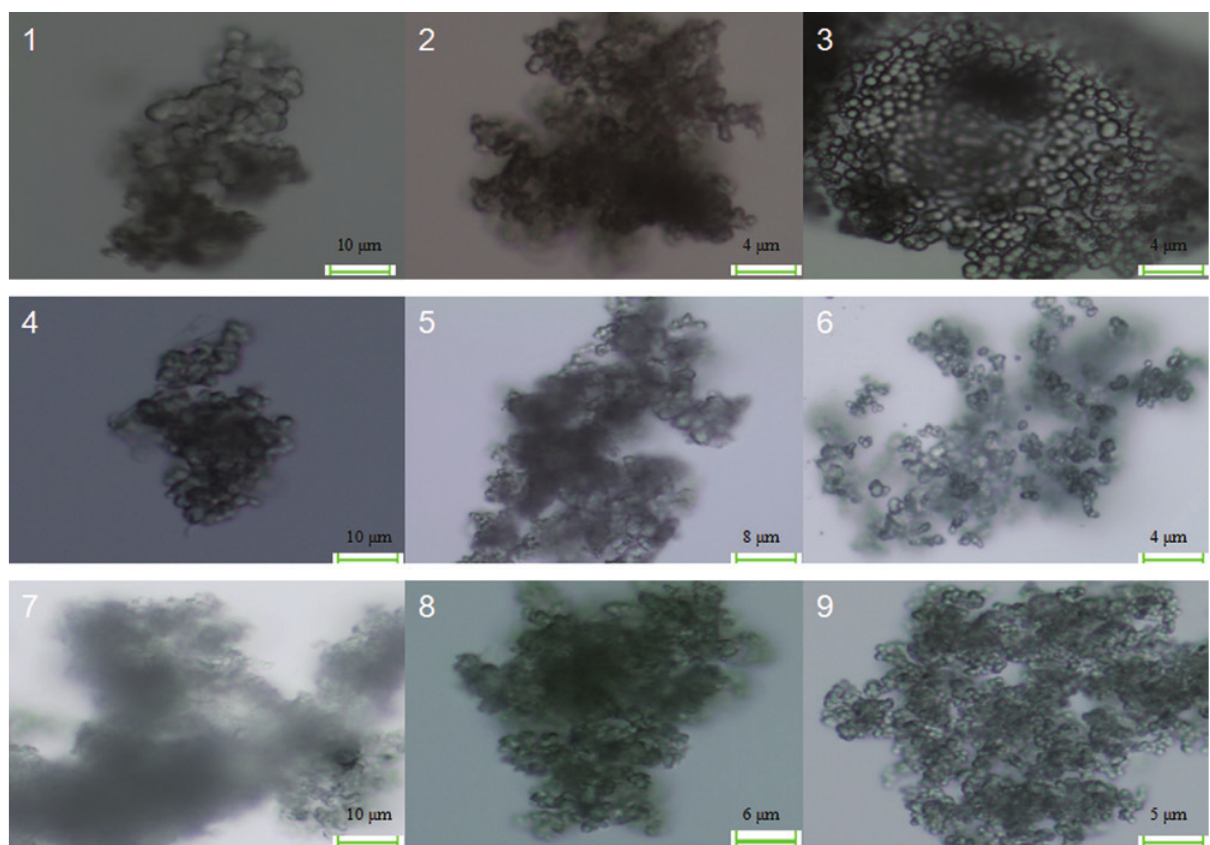
Figure 1: OM images of nanocapsule prepared in conditions of orthogonal test design.